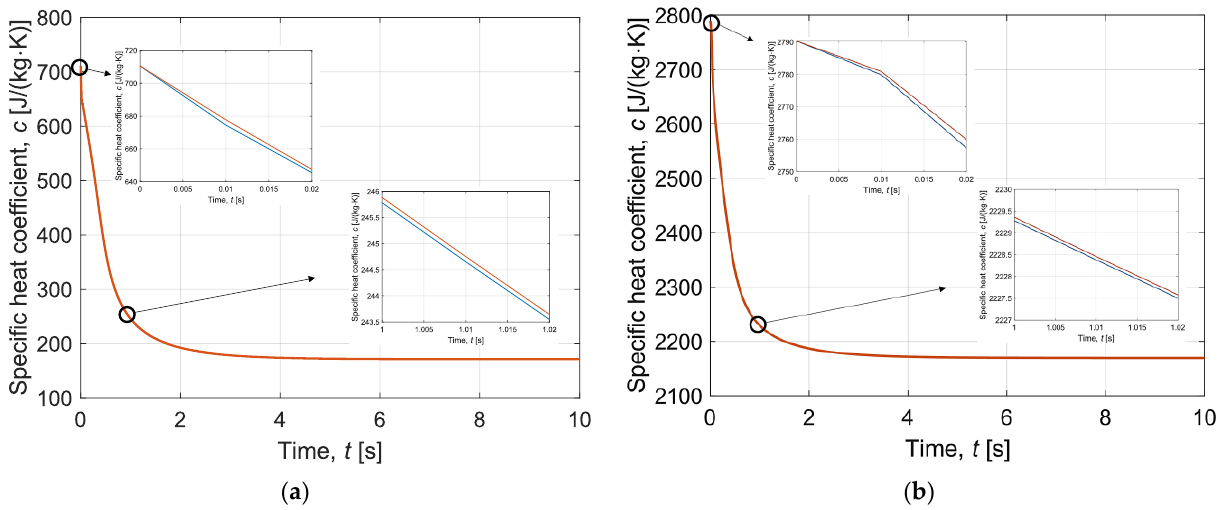
Figure 5. Specific heat coefficient as a function of time during cooling for ( a ) chip wall; ( b ) sample layer.